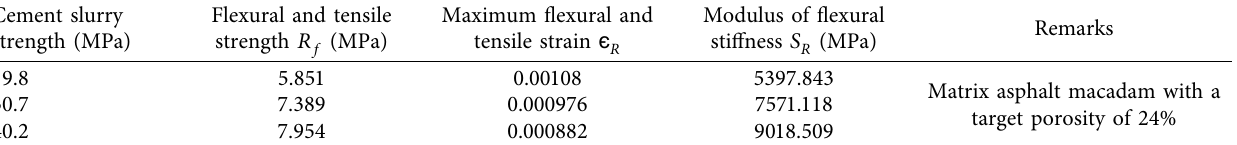
Table 20: Data processing results of low-temperature beam bending tests at diferent cement slurry strengths. Cement slurry strength (MPa)